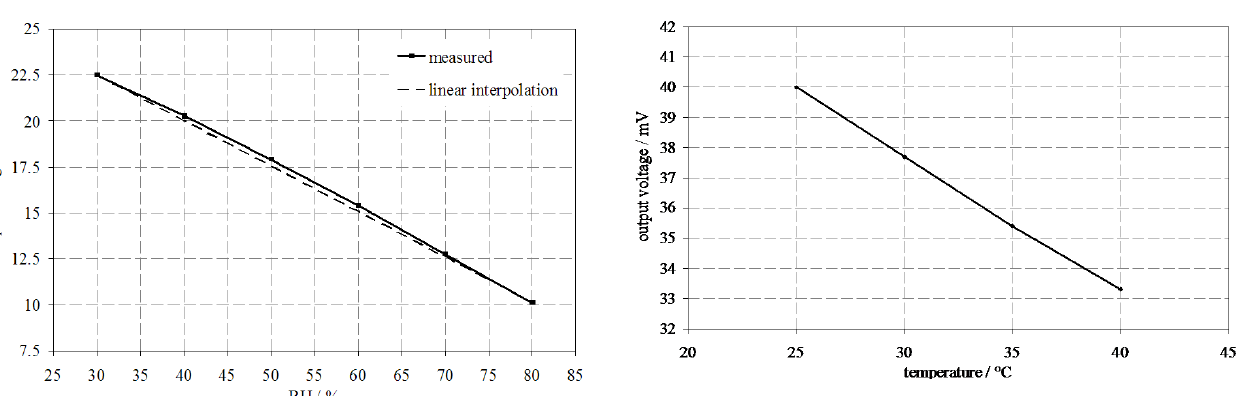
Figure 9. Bridge output voltage of the sensor at the relative humid- ity of 30%RH and at different temperatures. As can be seen, the sensor has a strong cross-sensitivity to temperature. By changing the temperature by 5 ◦ C, the output voltage alters by around 2.5mV.